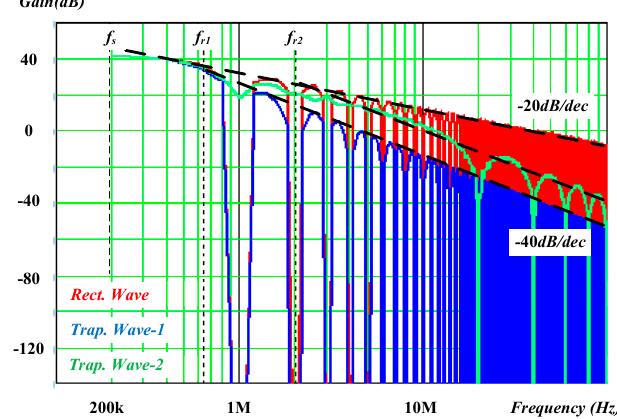
Figure 5. Fourier spectrum of a rectangular and trapezoidal waveform. Rect. Wave = a rectangular waveform; Trap. Wave-1 = a trapezoidal waveform of t r = t f = 500 ns; Trap. Wave-2 = a trapezoidal wave of t r = 500 ns, t f = 50 ns; f s = switching frequency; f r* = control by the trapezoidal wave.